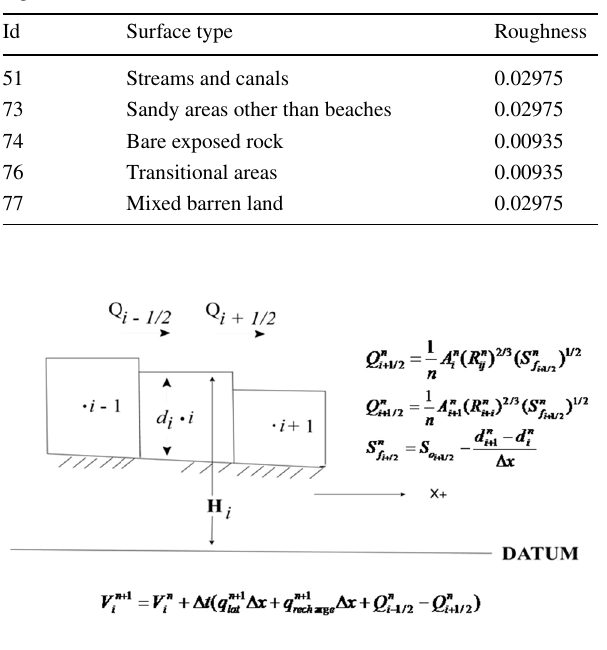
Fig. 1 Explicit channel routing